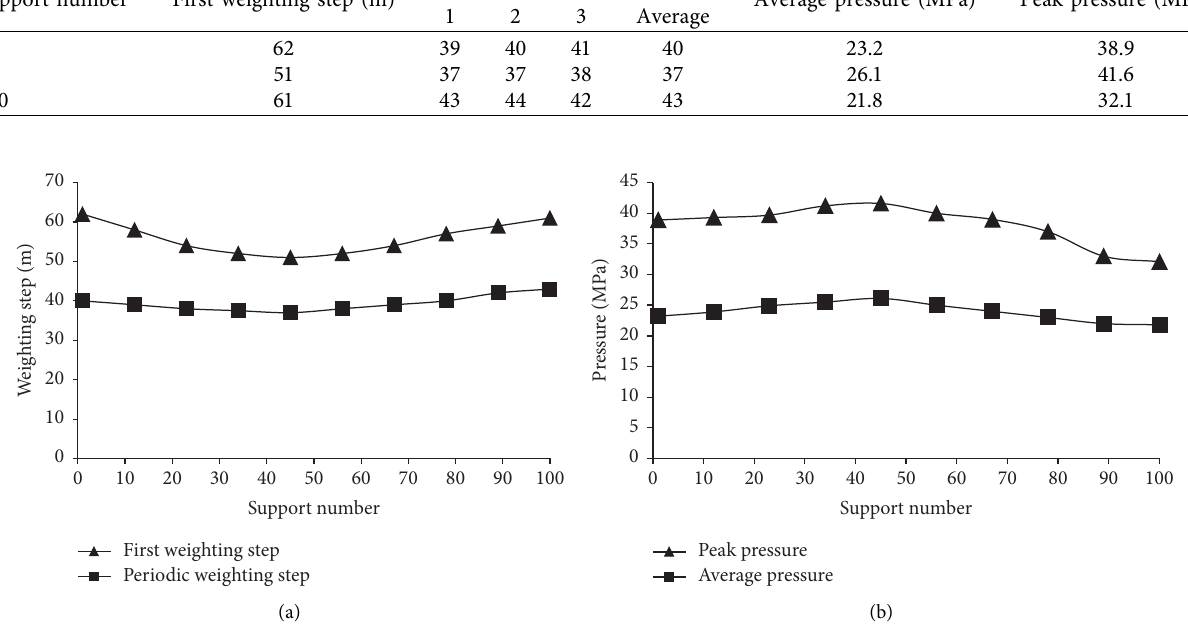
Figure 19: Pressure statistics of hydraulic support in working face. (a) Weighting step statist. (b) Weighting strength